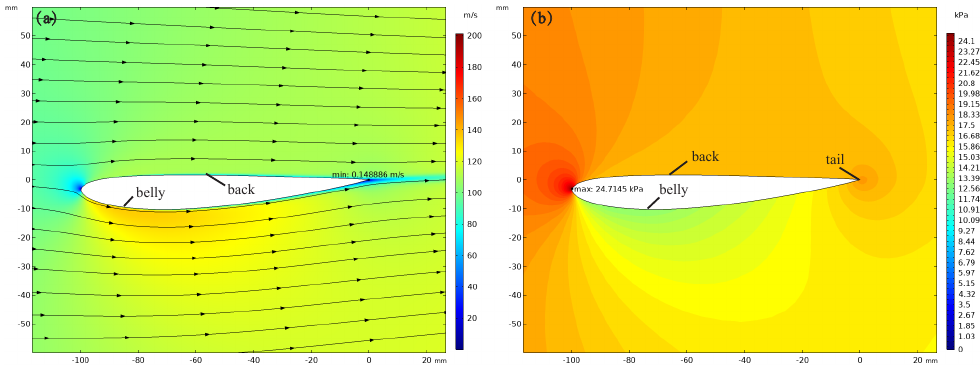
Figure 12. ( a ) Velocity distribution and ( b ) pressure distribution around the simplified